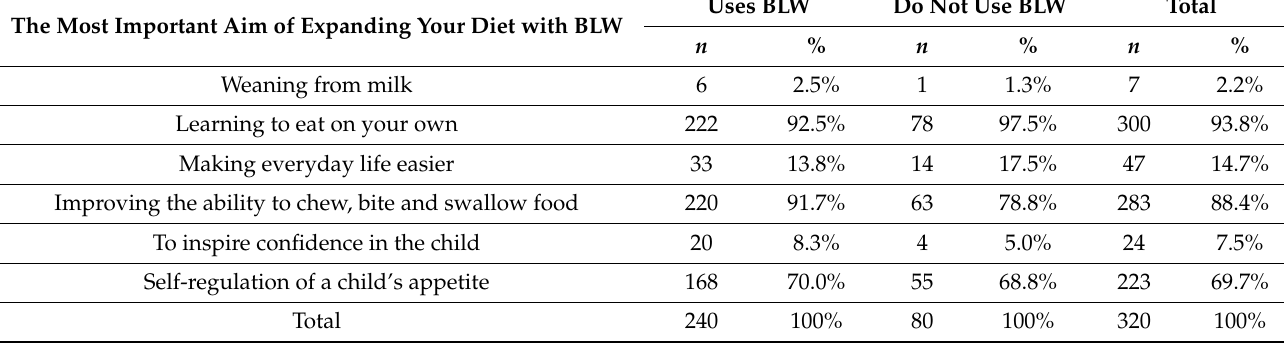
Table 8. “The most important aim of expanding the diet with BLW” survey—multiple choice answers—figures do not add up to